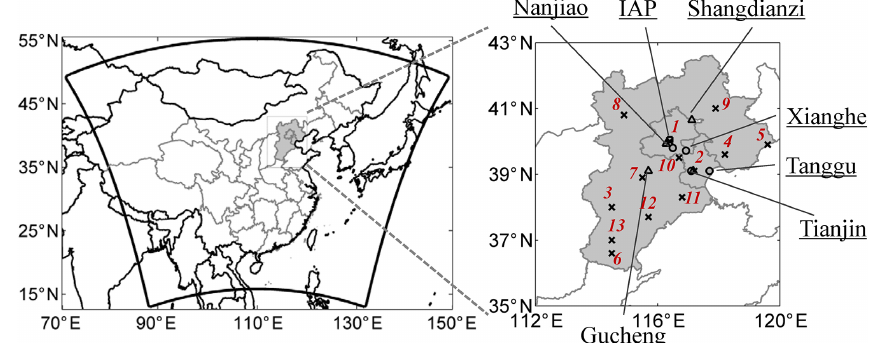
Figure 1. The model study domain. The shaded areas indicate the Beijing-Tianjin-Hebei (BTH) region. Markers are observation sites (squares represent IAP observations of PM 2 . 5 , its chemical components, aerosol extinction coefficient (EXT), and aerosol absorption coefficient (ABS); circles represent observations of meteorological variables; and triangles represent aerosol optical depth (AOD)). The Xianghe site provides meteorological soundings and hourly surface shortwave radiation (SWDOWN) measurements; the Tianjin site provides both me- teorological variables and AOD. Hourly O 3 , SO 2 , NO 2 , and PM 2 . 5 measurements at 13 cities from the CNEMC (China National Environ- mental Monitoring Center, http://www.cnemc.cn/, last access: 31 August 2019) are labeled by crosses with numbers (1-Beijing, 2-Tianjin, 3-Shijiazhuang, 4-Tangshan, 5-Qinhuangdao, 6-Handan, 7-Baoding, 8-Zhangjiakou, 9-Chengde, 10-Langfang, 11-Cangzhou, 12-Hengshui, and